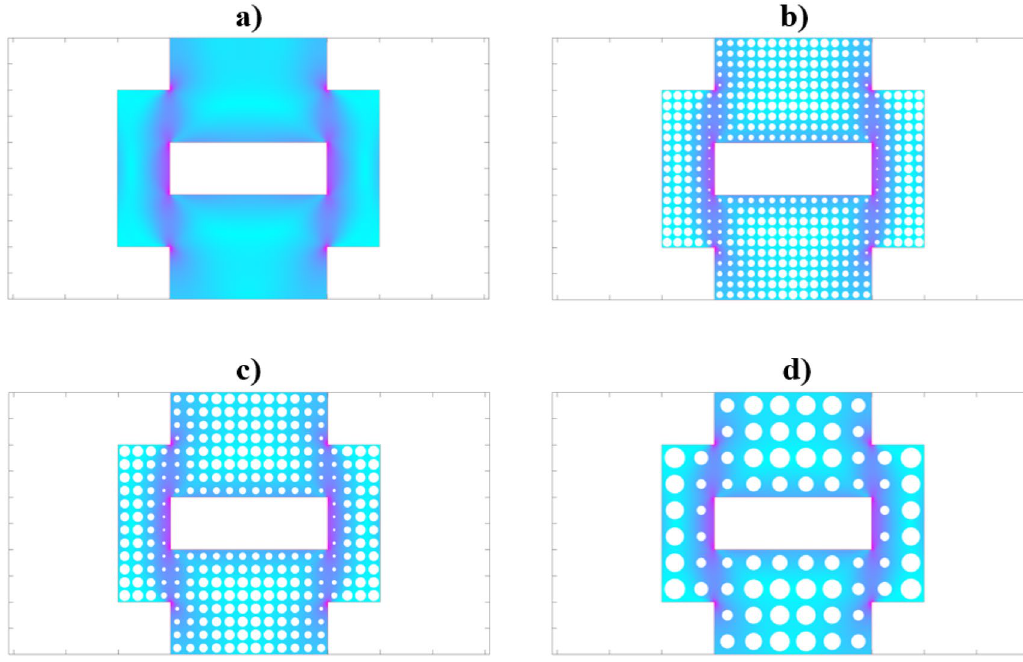
Figure 4. Results of the optimization ( a ) original surface geometry, ( b ) optimized with 4 × 4 unit cell, ( c ) optimized with 5 × 5 unit cell, and ( d ) optimized with 10 × 10 unit